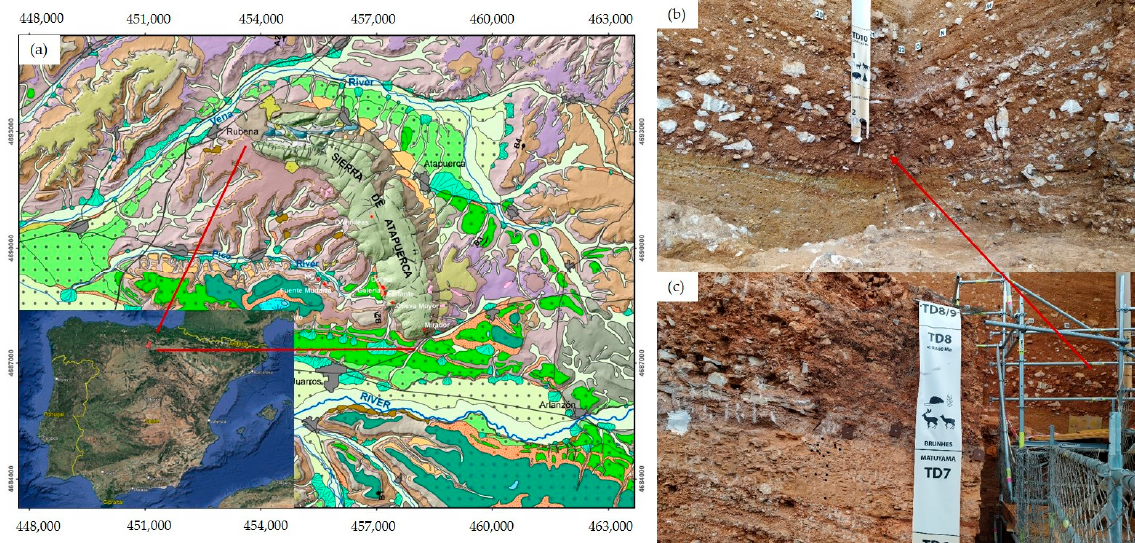
Figure 1. Location of the archaeological site in the Sierra de Atapuerca. ( a ) Geomorphological map of the Sierra de Atapuerca, also respective to location in Spain. ( b ) Inner corner of the highest units of this cave, from which we have taken samples of TD9–TD10 units. ( c ) Front view of the studied profile analysed, from units TD6 to TD8.9. The photographs ( b , c ) were taken in summer 2021. The chronology of the sedimentary infill is due to paleomagnetism, ESR, U-series, and OSL ([17–20] and references therein). For this study, it is important to highlight